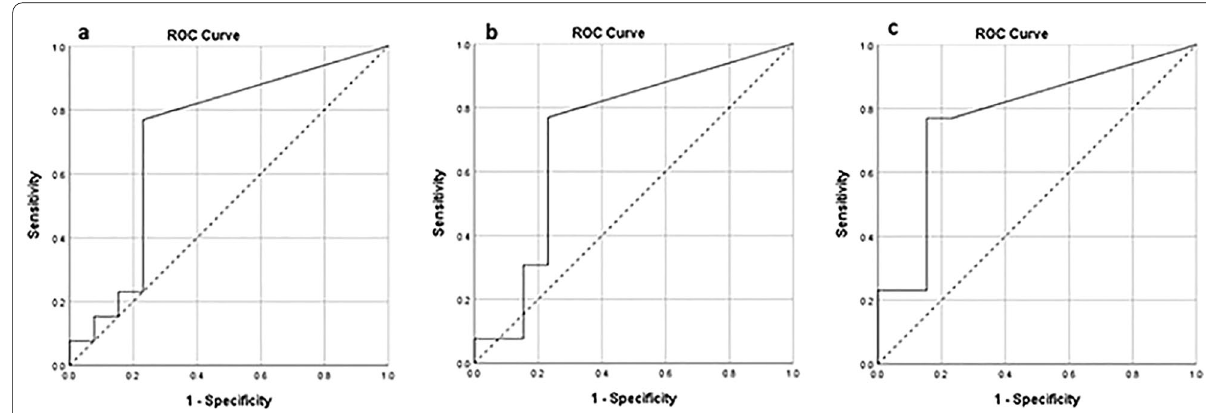
Fig. 2 Roc curves for predicting tumor response to TACE. a D had an AUC of 0.716, b D* had an AUC of 0.716, and c f had an AUC of 0.775